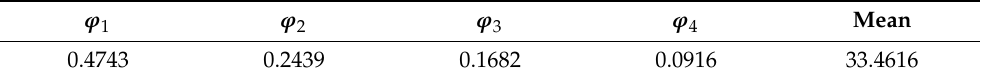
Table 4. Autoregressive integrated moving average (ARIMA) correlation coefficients (4, 0, 0).